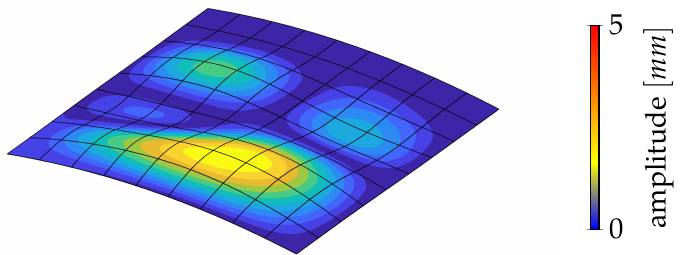
Figure 7. Worst-case geometrical imperfection detected in stage 1 for the optimal distribution of lamination parameters [35].